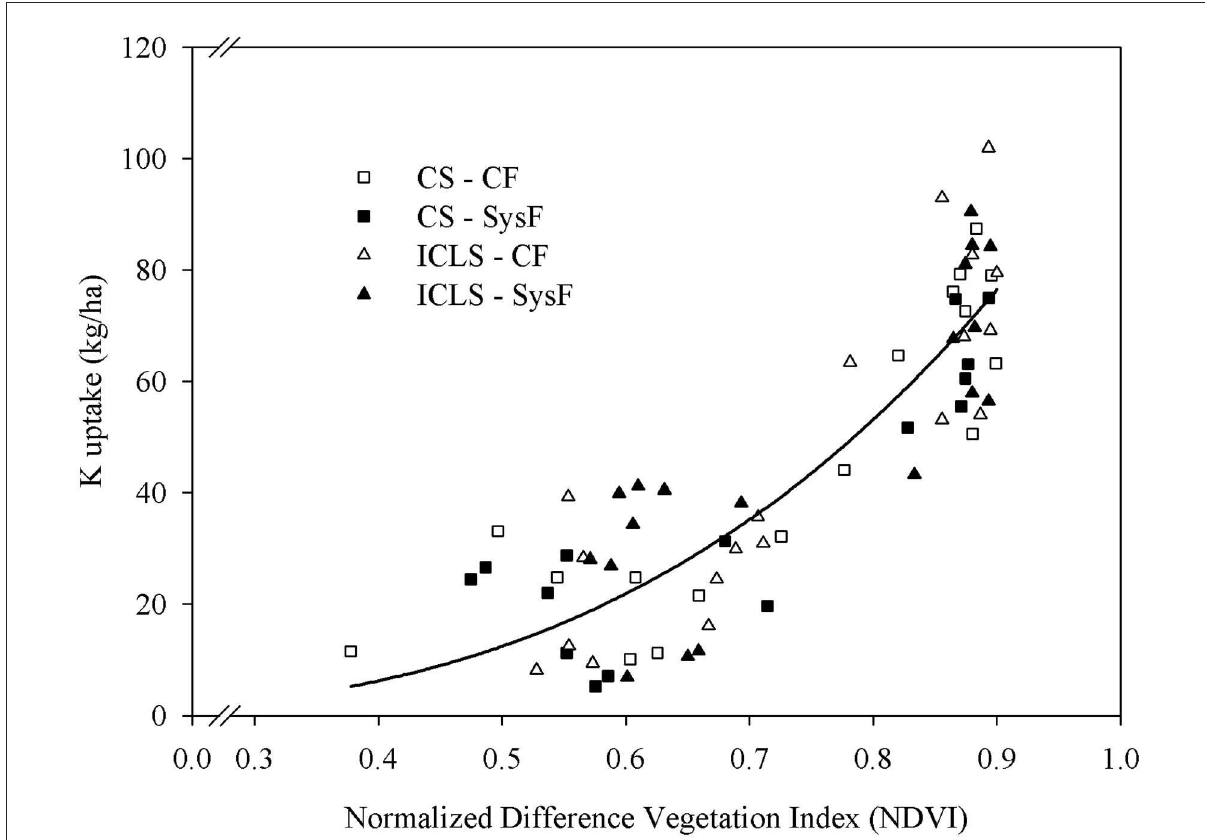
FIGURE6 Relationship between potassium (K) uptake and the Normalized Difference Vegetation Index under the cropping system with crop fertilization (CS–CF), the cropping system with system fertilization (CS–SysF), the integrated crop-livestock system with crop fertilization (ICLS–CF), or the integrated crop-livestock system with system fertilization